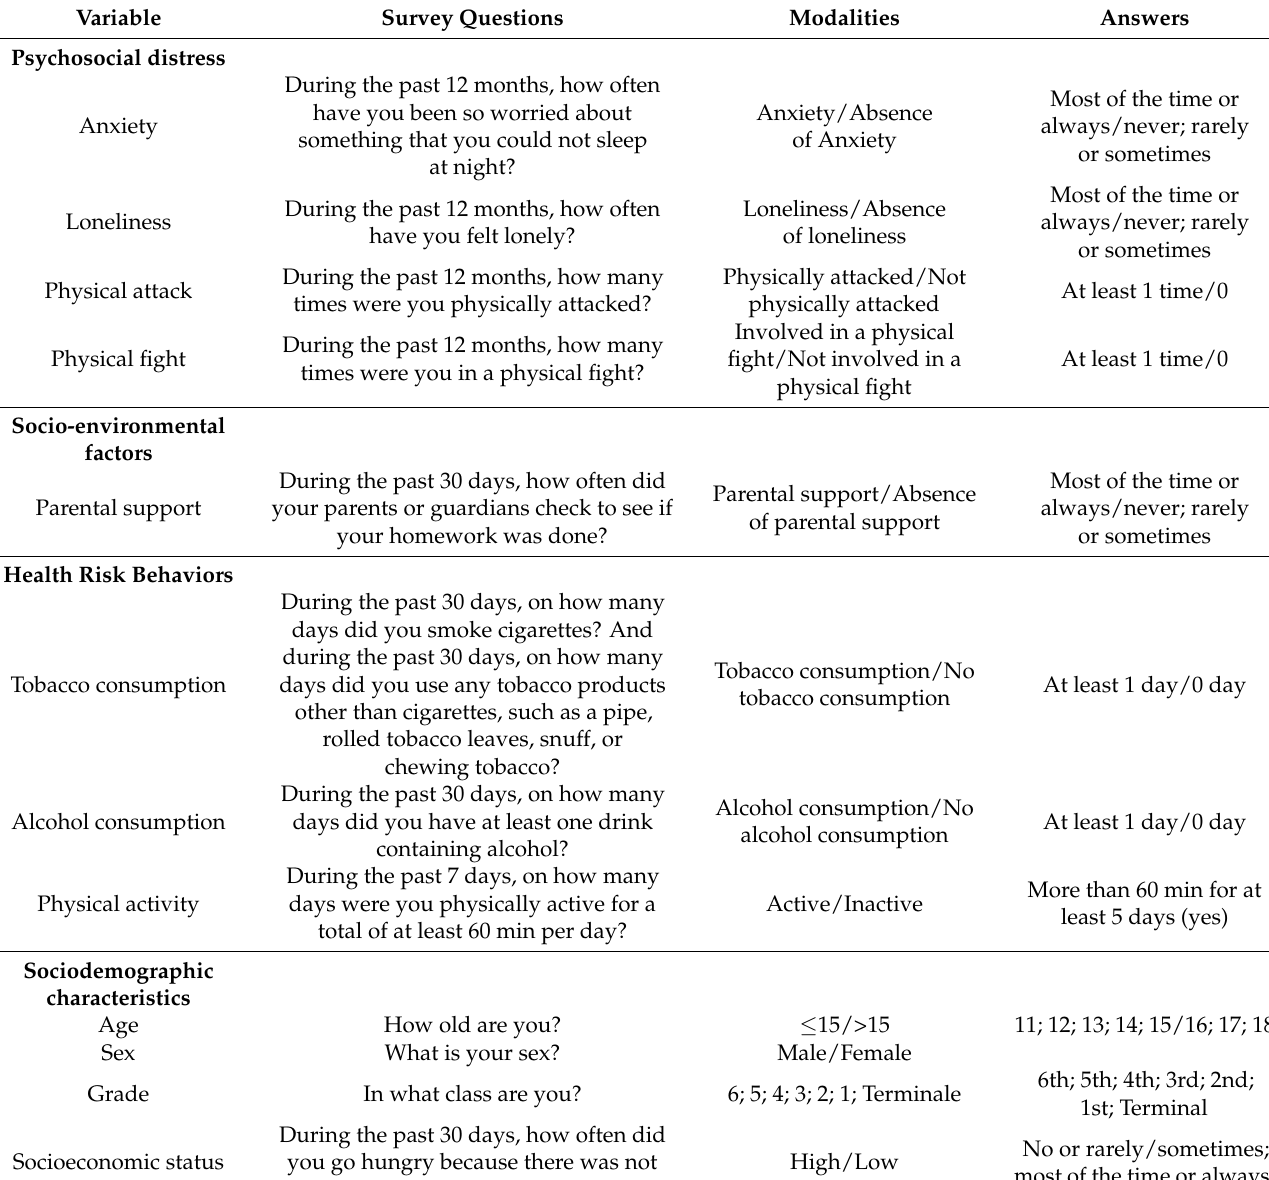
Table 1. Survey questions and answers used to assess sociodemographic characteristics and health-related lifestyle habits in adolescents aged 11–18 in Benin,